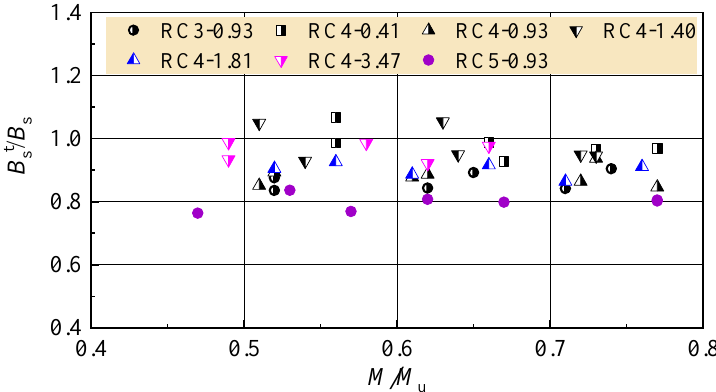
Figure 10. Ratios of test to computed flexural stiffness.